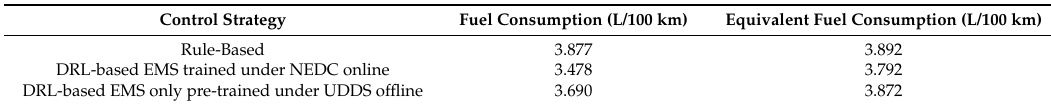
Table 5. Comparison of the results under NEDC.